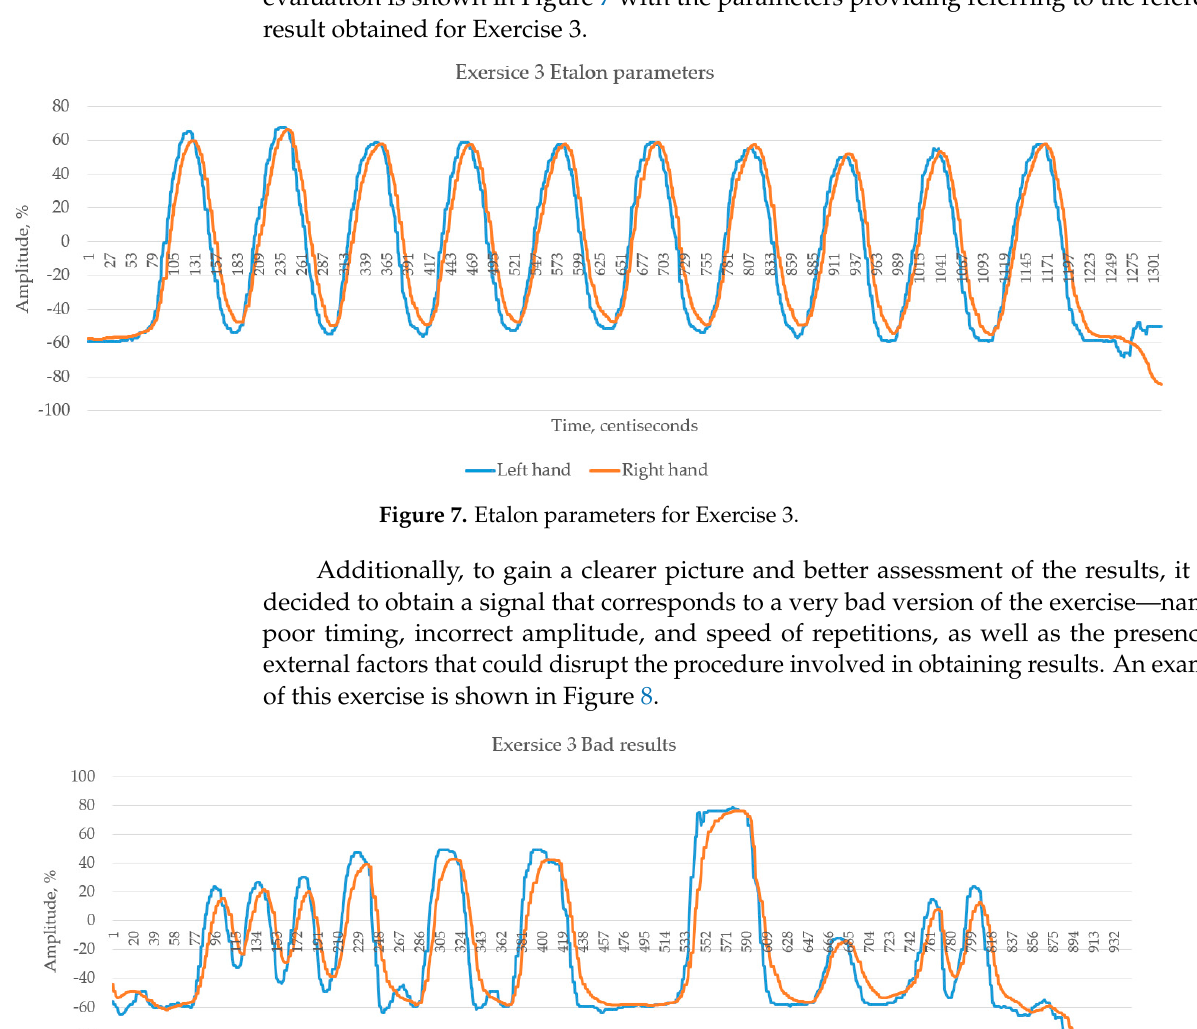
Figure 9. Result of normal performance in Exercise 3. Figure 10. Result of game performance in Exercise 3.